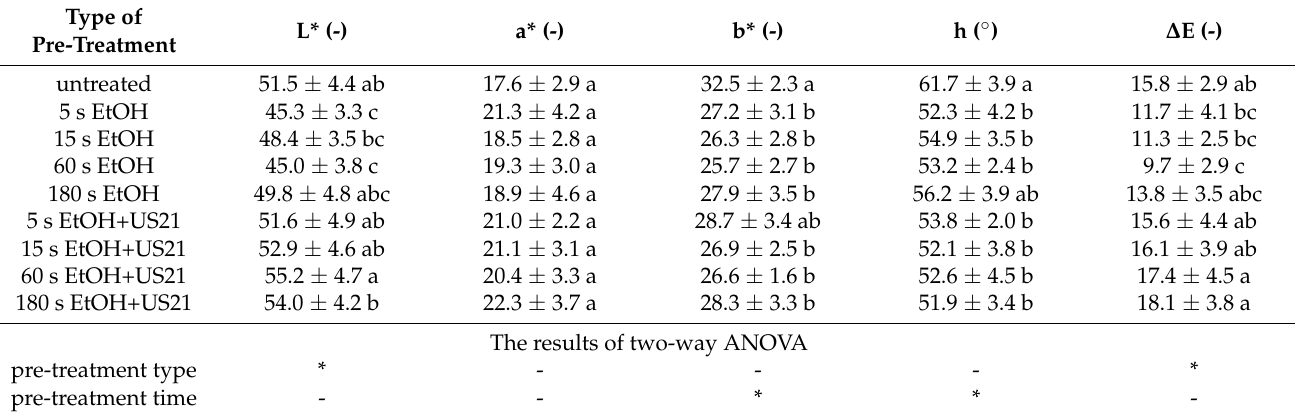
Table 5. Colour parameters (L*, a*, b*), hue angle (h ◦ ) and total colour difference ( ∆ E, in comparison to raw material) of carrot tissue pre-treated in ethanol without (EtOH) and with ultrasound (EtOH+US21); error bars indicate ± SD (standard deviation calculated from at least six